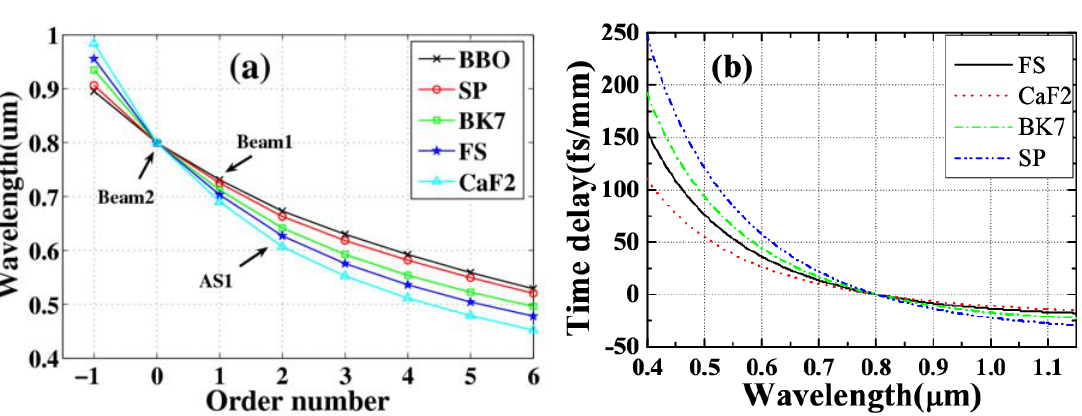
Figure 37. (a) Dependence of the wavelength of generated sidebands on the order number , fused silica, BK7, sapphire plate, and BBO crystal) when the in five different media (CaF 2 crossing angle is 1.8º. (b) The group delay between beam2 (800 nm) and other wavelength , fused silica, BK7, and sapphire plate with 1mm thickness in CaF 2